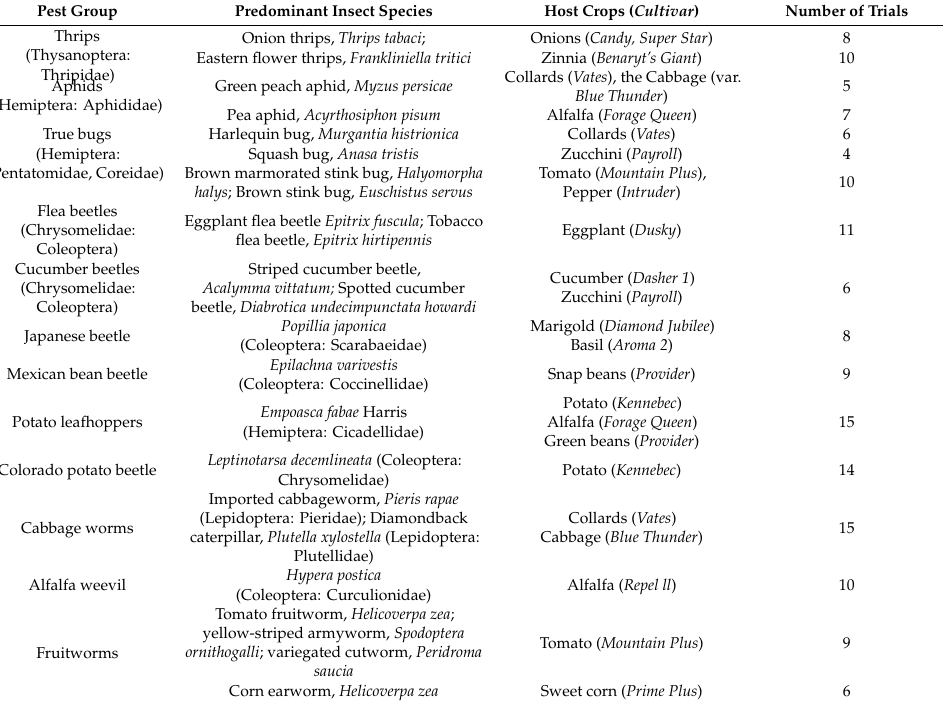
Table 1. Insect pest / crop groups evaluated in the